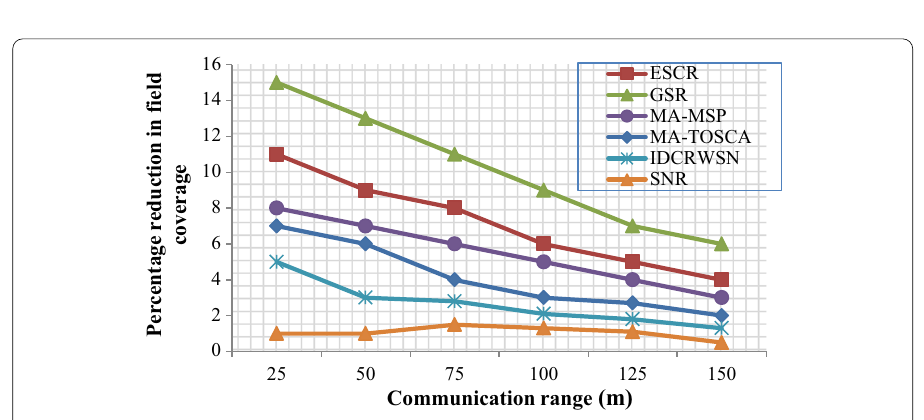
Fig. 11 Percentage reduction in field